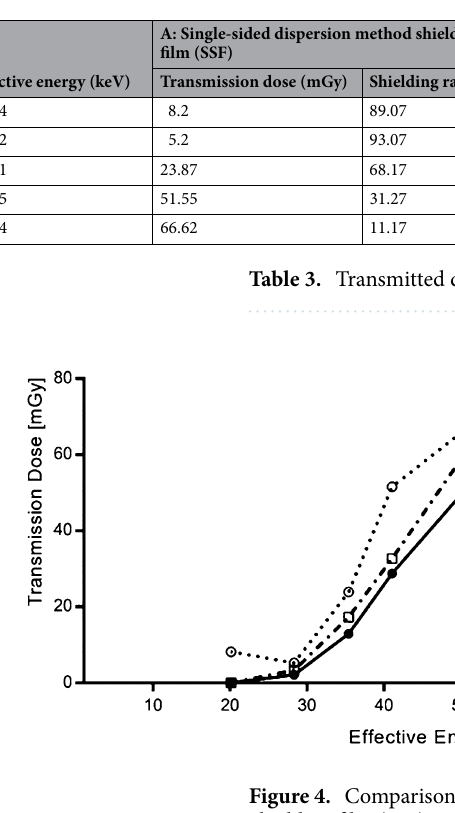
Figure 4. Comparison of transmission dose and shielding performance of Single-sided dispersion method Shielding film (SSF), Double-dispersion method Shielding film (DSF), and Air pressure mirroring particle